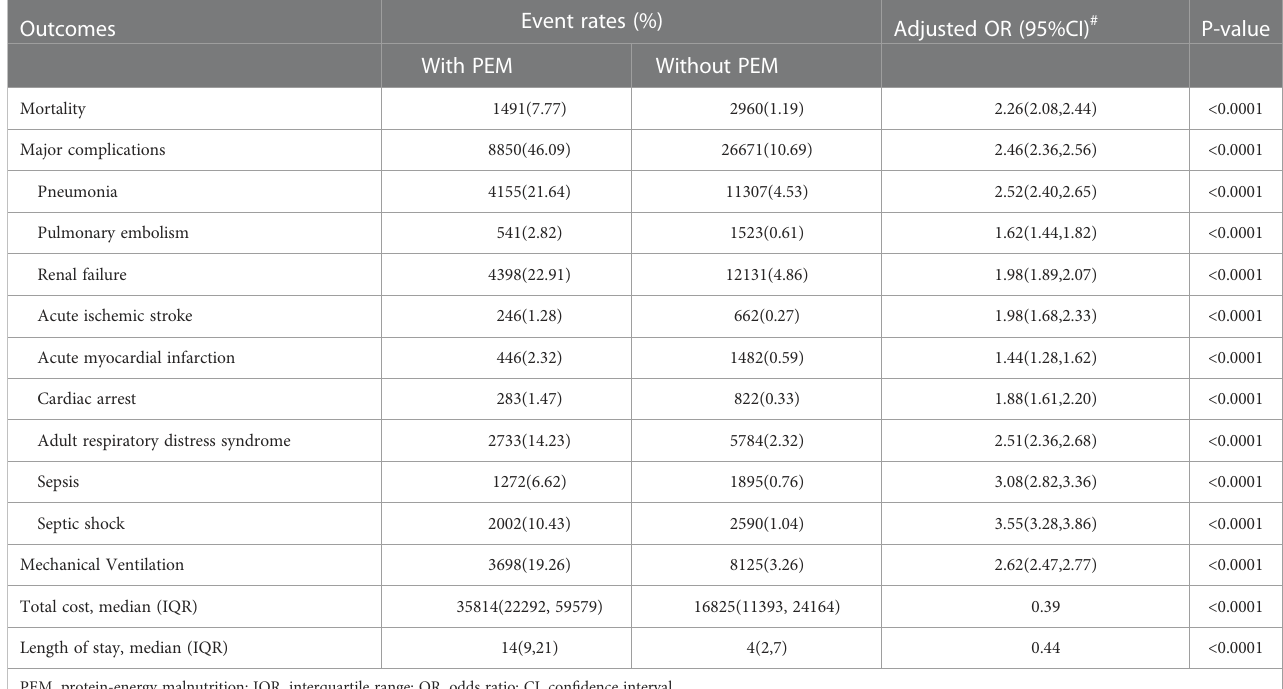
TABLE 2 Comparison of clinical outcomes following major cancer surgery in patients with and without PEM.